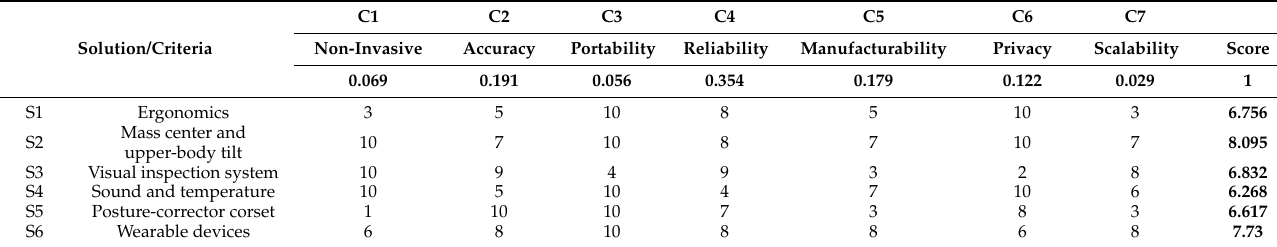
Table 2. PUGH matrix for the available